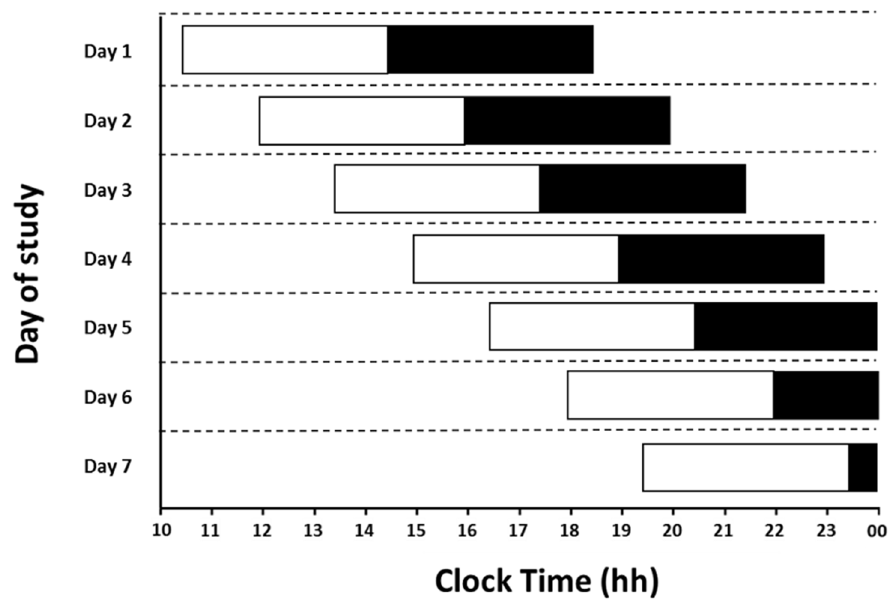
Figure 1. Light exposure protocol. White bars = period to seek bright light; black bars = period to avoid